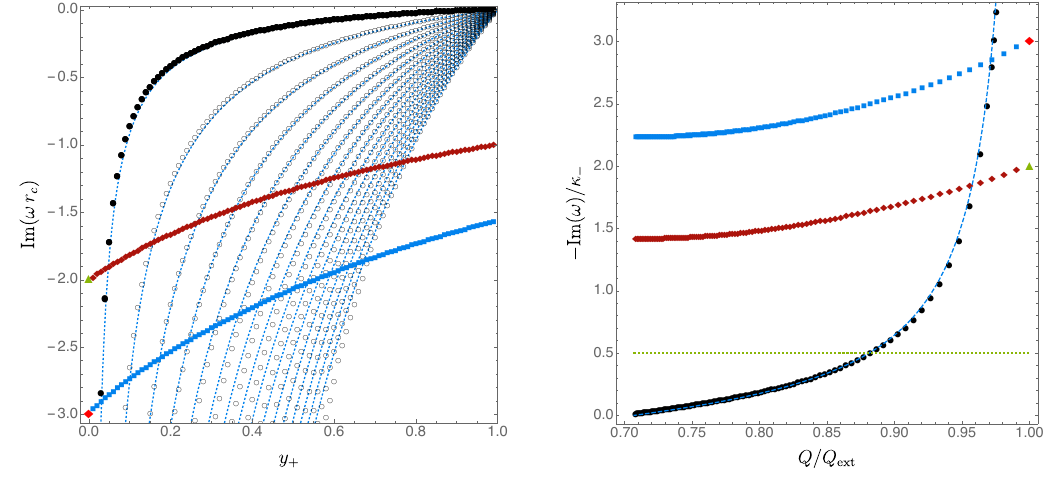
Figure 7 . Results for the (cid:8) (cid:0) quasinormal modes with ‘ = 2 for lukewarm RNdS black holes. Left panel: the (cid:12)lled marks identify the fundamental ( n = 0) modes of the three families, namely photon sphere (black disks), near-extremal (red diamonds), and de Sitter (blue squares). The black circles represent the next 15 photon sphere overtones ( n = 1 ; (cid:1) (cid:1) (cid:1) ; 15) and the 16 blue dotted lines represent the WKB approximation Im ( ! WKB ) ( n ), n = 0 ; (cid:1) (cid:1) (cid:1) ; 15, for the photon sphere modes (valid for ‘ (cid:29) 1). The red diamond (in the de Sitter curve) represents the n = 0 pure de Sitter frequency Im( ! r c ) j dS = (cid:0) 3. The green triangle (in the near-extremal curve) represents the n = 0 analytical approximation Im( ! r c ) j NE = (cid:0) 2 in the limit where Q = Q ext , which for lukewarm RNdS occurs when y + ! 0. Right panel: the three families of fundamental ( n = 0) quasinormal modes. Here we plot (cid:0) Im( ! ) =(cid:20) (cid:0) against Q=Q ext . The colour code is the same as for the left panel. p with Q=Q = 1 = 2 (cid:24) 0 : 707 for y = 1 and Q=Q = 1 for y = 0. We have ext + ext +